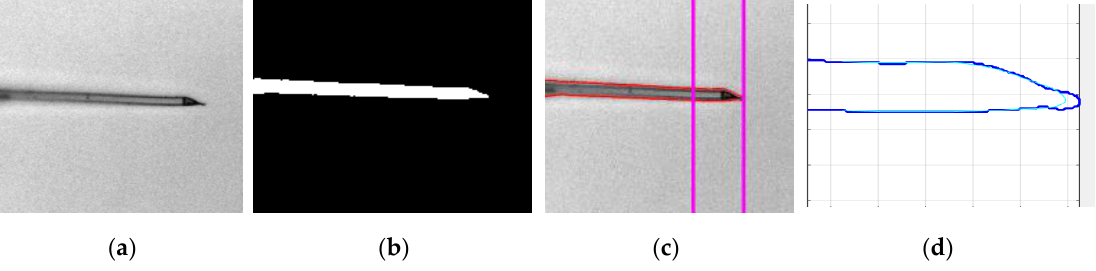
Figure 5. Region of interest extraction: ( a ) original injection pipette image; ( b ) final binary image; ( c ) image with a boundary at the ratio of 1:4 divided by lines; ( d ) extraction of the region of Interest.